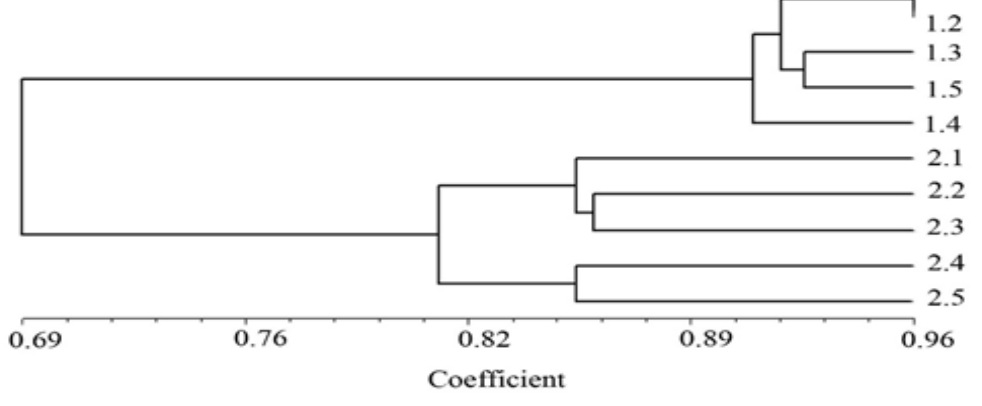
Figure 3. The dendrogram constructed from 25 primers by the NTSYSpc 2.10 program showing genetic relationships of the hybrid catfish samples between the reference catfish (1.1 – 1.5) and landfill catfish (2.1 – 2.5).